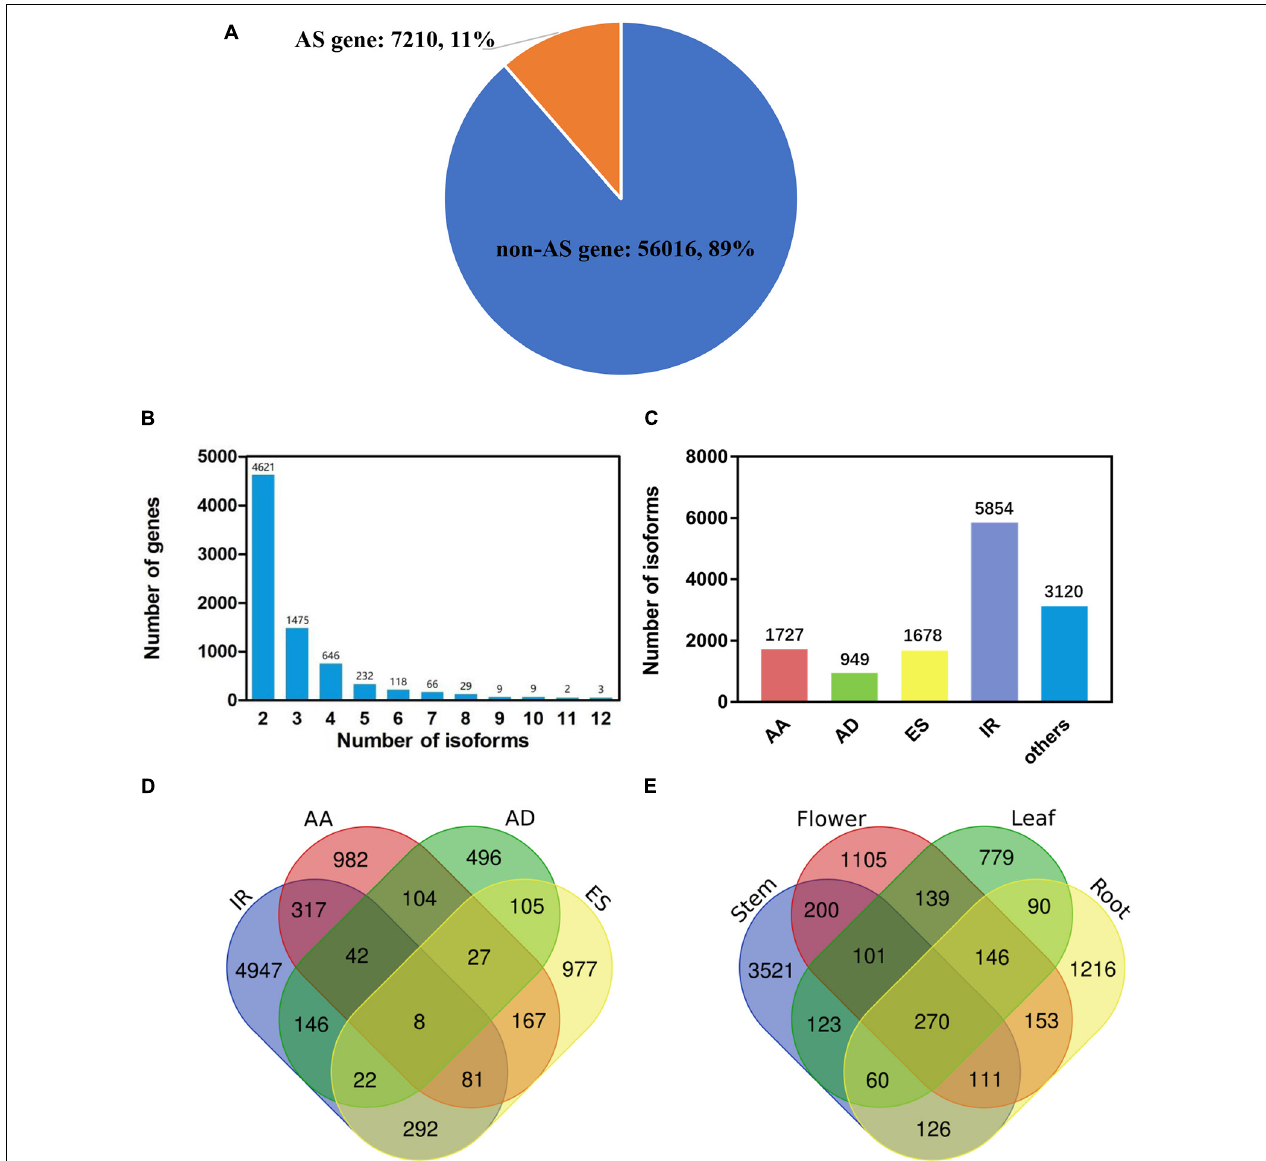
FIGURE 1 | Identification and classification of gene isoforms in Artemisia annua L. (A) The number and proportion of AS and non-AS gene. (B) The number distribution of alternatively spliced isoforms per gene. (C) Types of alternatively spliced isoforms: AA, alternative 3 (cid:48) splice site; AD, alternative 5 (cid:48) splice site; ES, exon skipping; IR, intron retention. (D) The number of isoforms produced by one or more splicing mechanisms. Venn diagram shows the combination of the four types of isoforms. (E) The number of new isoforms found in leaf, flower, stem and root. Venn diagram shows the common and specific isoforms in different